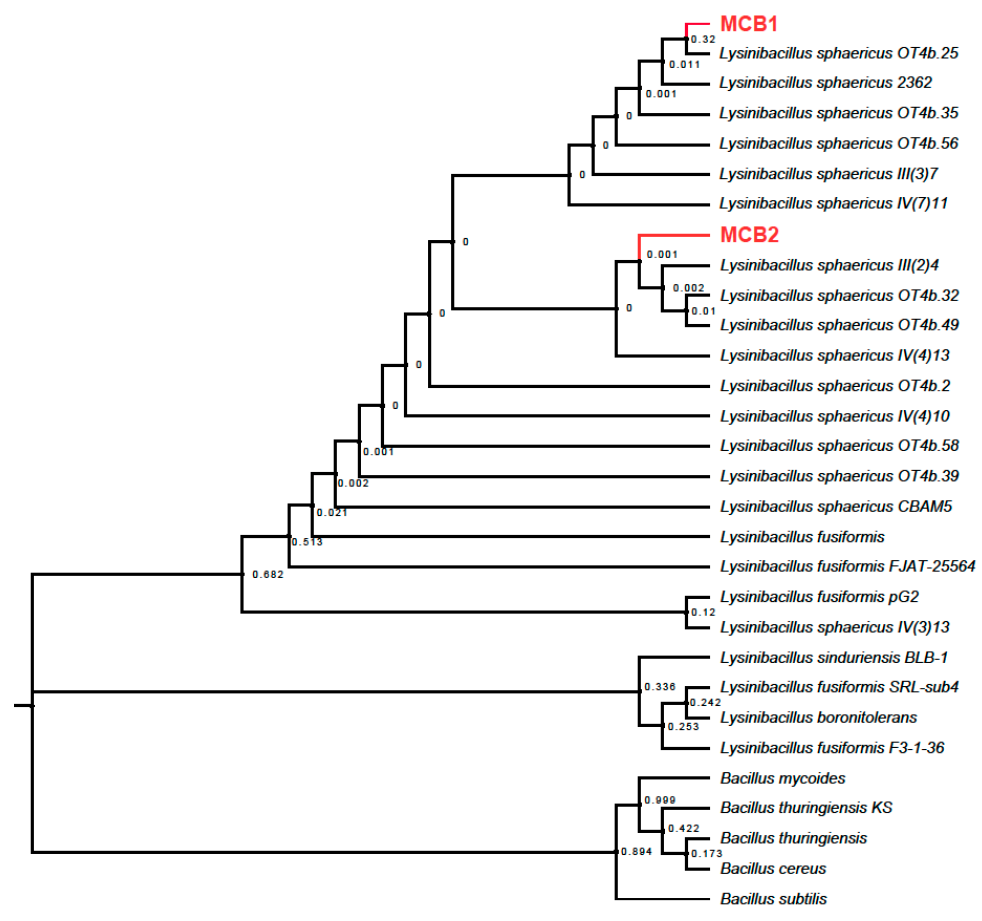
Figure 1. Phylogenetic tree for Lysinibacillus sphaericus with the two new strains isolated, MCB1 and MCB2.